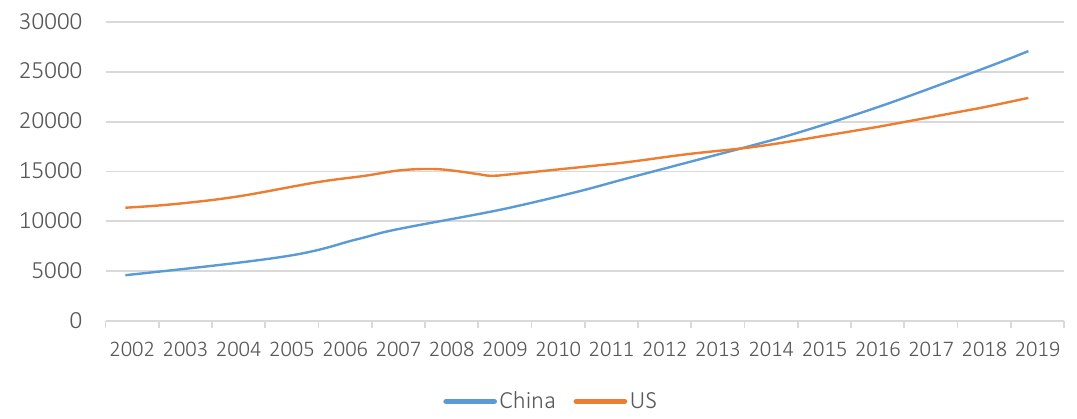
Source: Socio-Economic History Blog